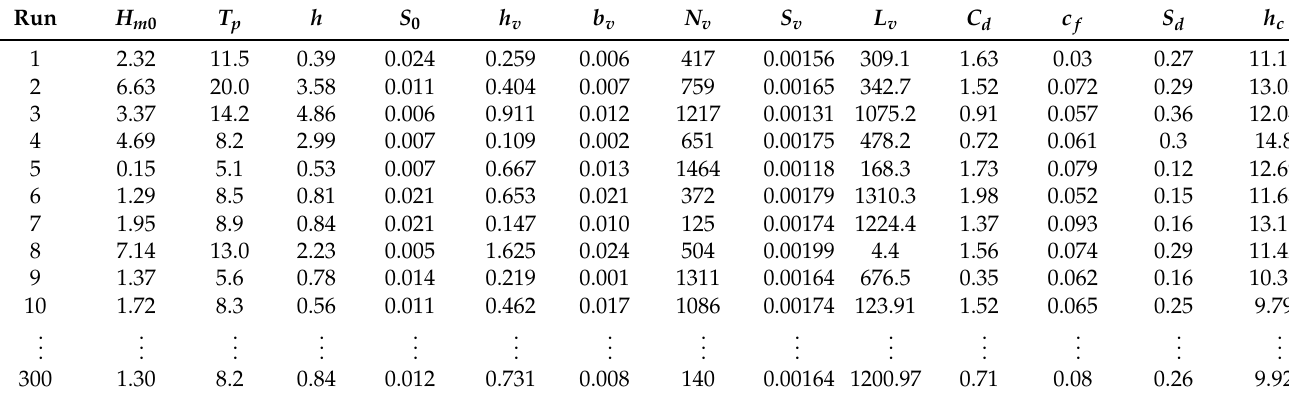
Table 6. Monte Carlo samples from NPBN for salt marsh environments.